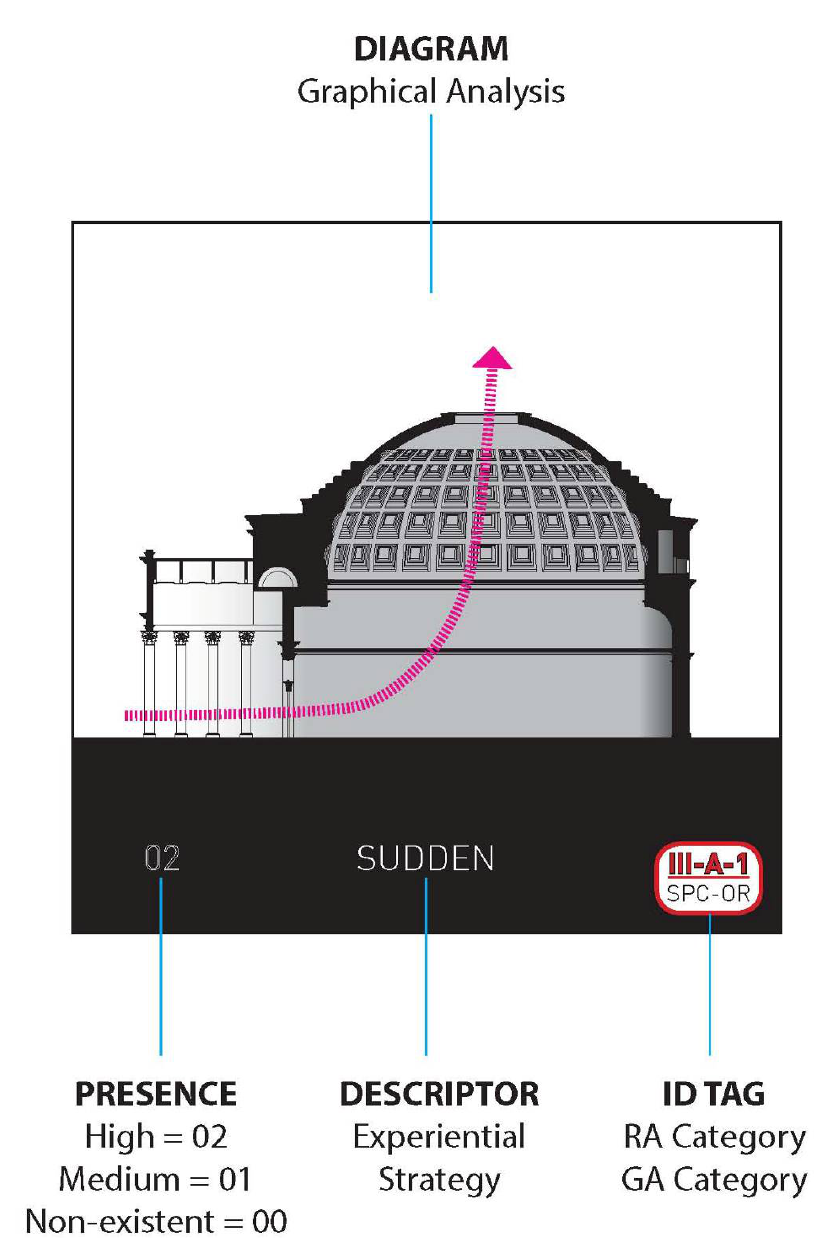
Figure 4. Overview of graphical analysis coding procedure. The number on the bottom left of the diagram designates how present a particular category is for the case study. The bottom middle section is a descriptor word describing the experiential strategy. The ID Tag on the lower right corner corresponds to Jones’ “morphology of ritual-architectural priorities” (RA), such as the “solicit involvement theatre” (III-A-1) category. The number underneath pertains to the “graphic analysis” (GA) categories, such as “Space” (SPC) and “Organization” (OR). Table 4. Six questions for researchers to ask for Jones’ ritual contexts during graphical analysis for a particular case study.